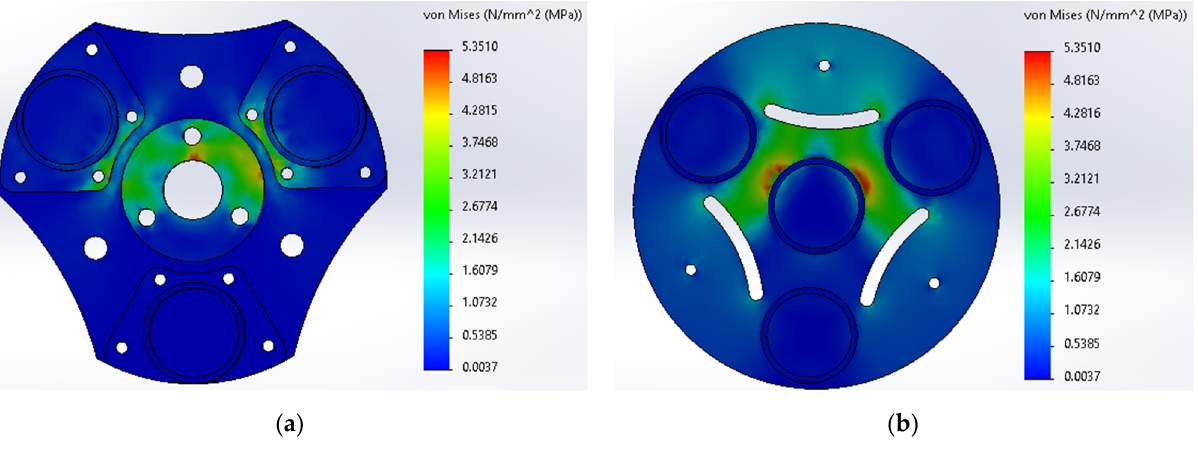
Figure 7. The simulation result of the structural analysis: ( a ) stress distribution on BOM when two chambers bend; ( b ) results under the same simulation conditions on RC.